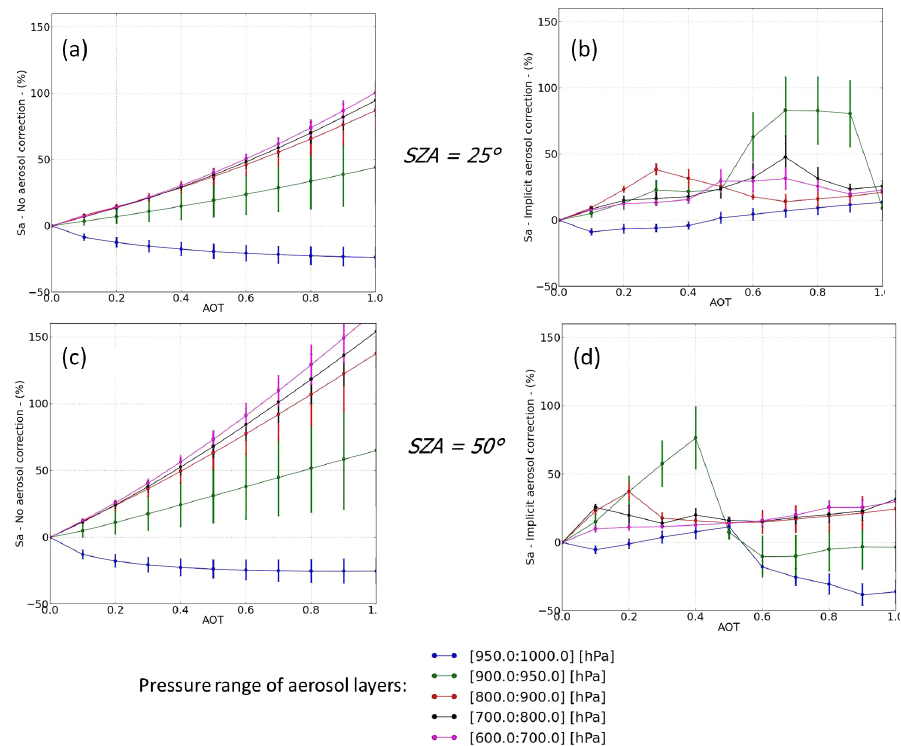
Figure 17. Similar to Fig. 14 but with NO 2 profiles for January and SZA = 50 ◦ : (a) S A assuming no aerosol correction is applied, January NO 2 profiles, (b) S A assuming implicit aerosol correction through the OMI cloud retrieval algorithm, January NO 2 profiles, (c) S A assuming no aerosol correction is applied, aerosols, January NO 2 profiles and SZA = 50 ◦ , (d) S A assuming implicit aerosol correction through the OMI cloud retrieval algorithm, January NO 2 profiles and SZA = 50 ◦